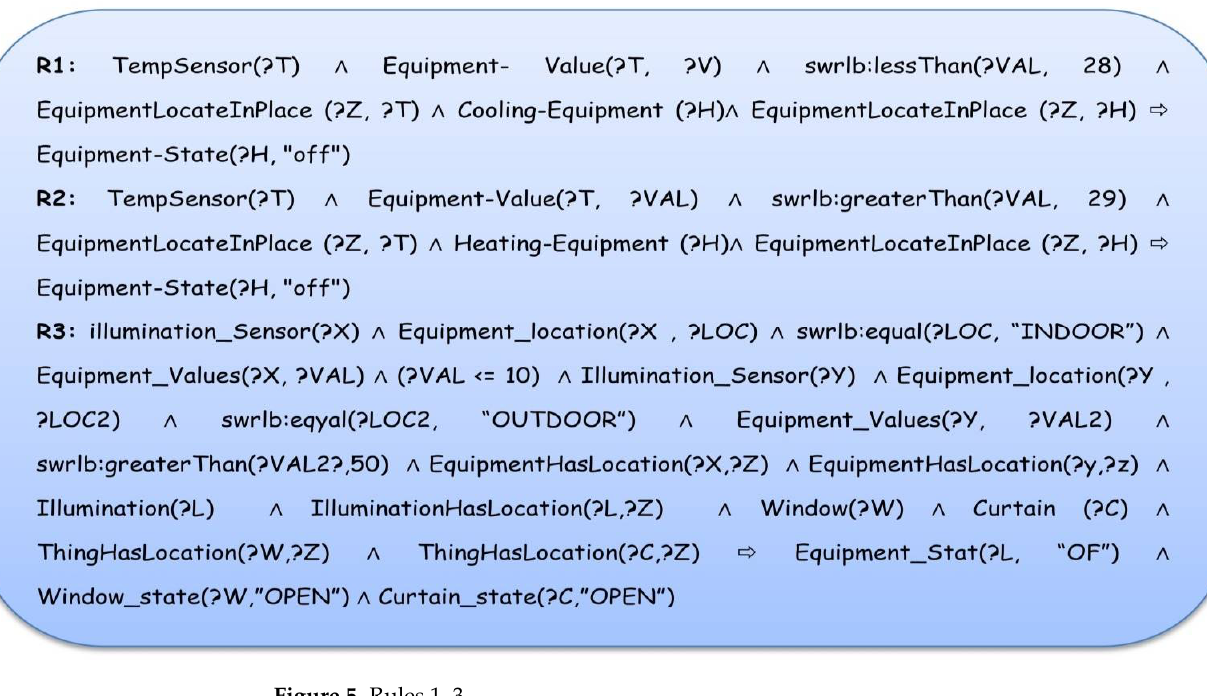
Figure 5. Rules 1-3.